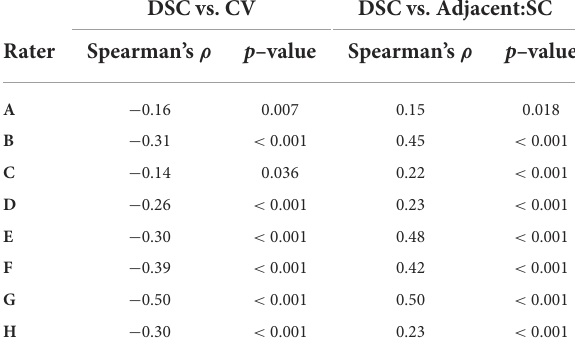
TABLE 2 Spearman correlations between rater agreement (DSC) with reference masks and coefficient of variation (CV) and adjacent: SC ratio across all participants and slices ( n =